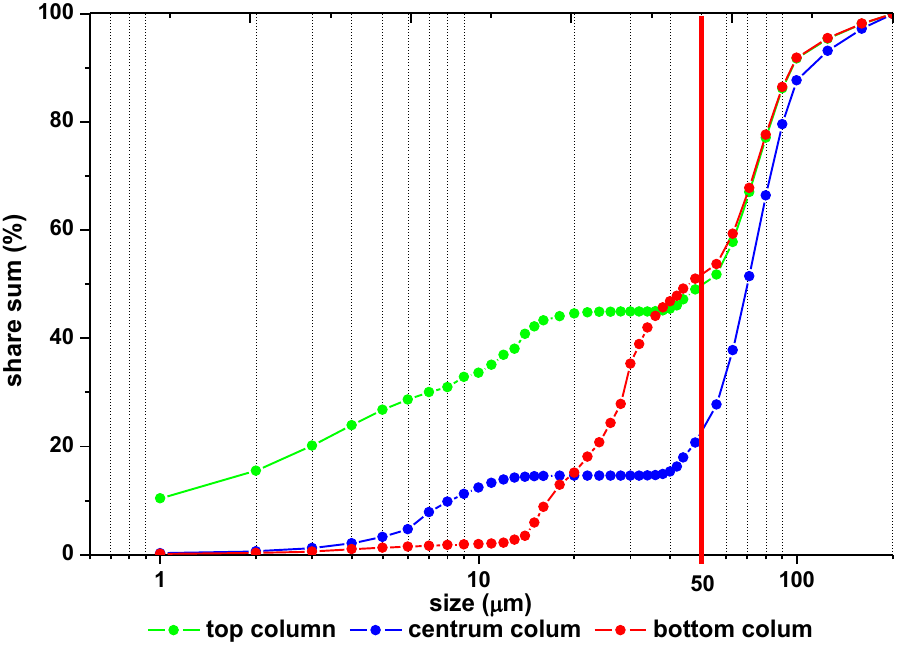
Figure 11. Distribution of grain classes at each level of column 1.